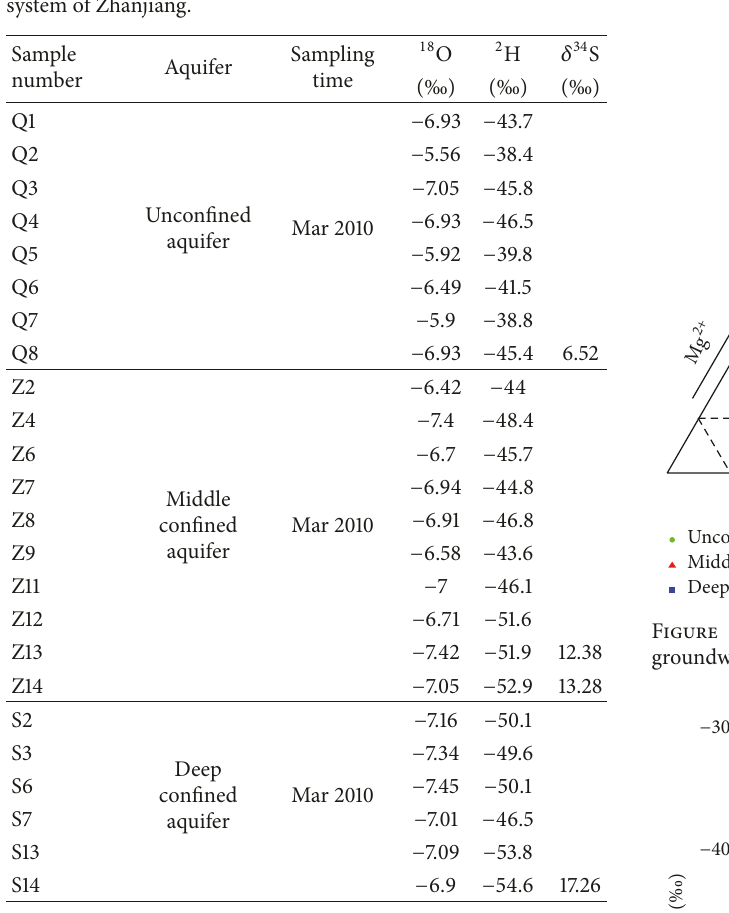
Table 2: Isotope data of groundwater in the multilayered aquifer system of Zhanjiang.